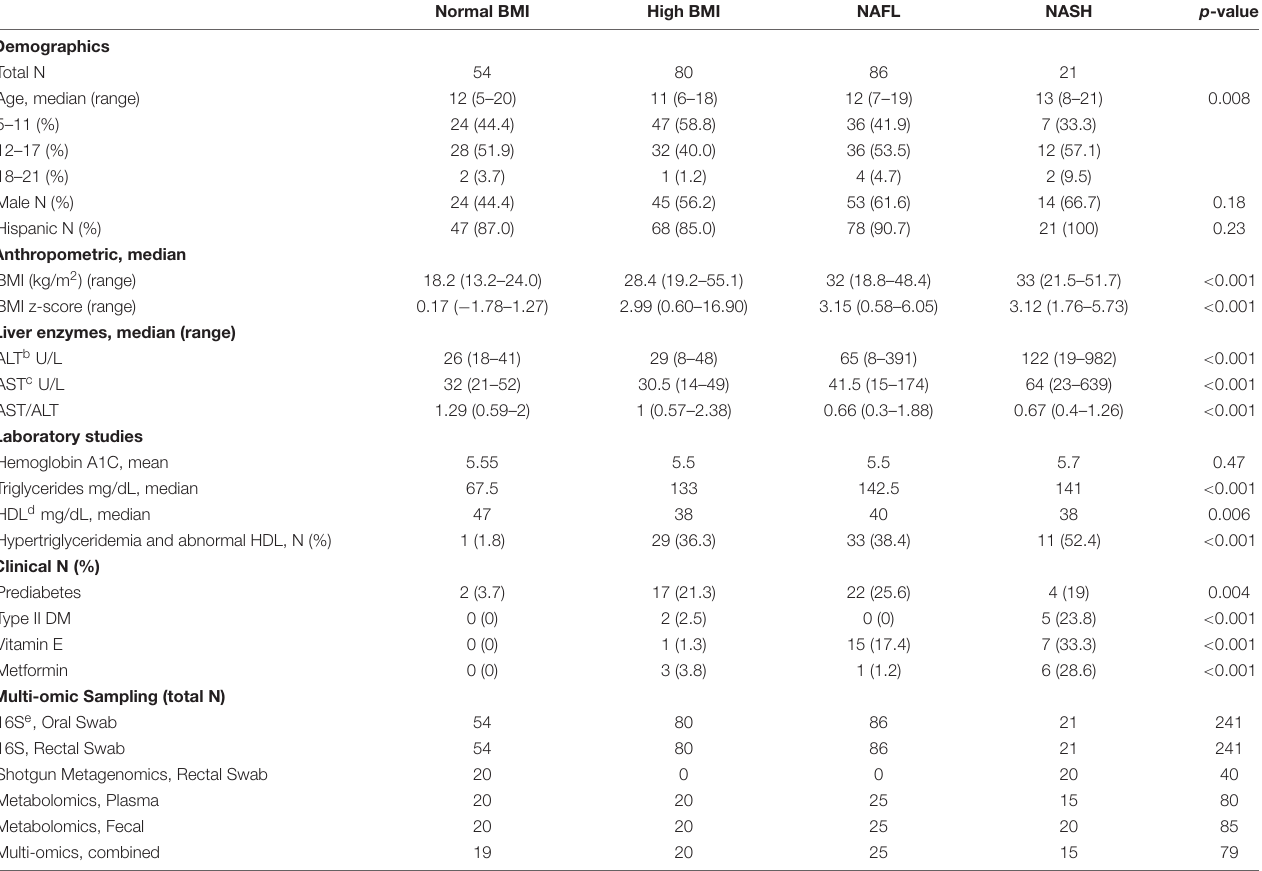
TABLE 1 | Baseline characteristics and multi-omic sampling for the 241 subjects enrolled in the study. Normal BMI High BMI NAFL NASH p